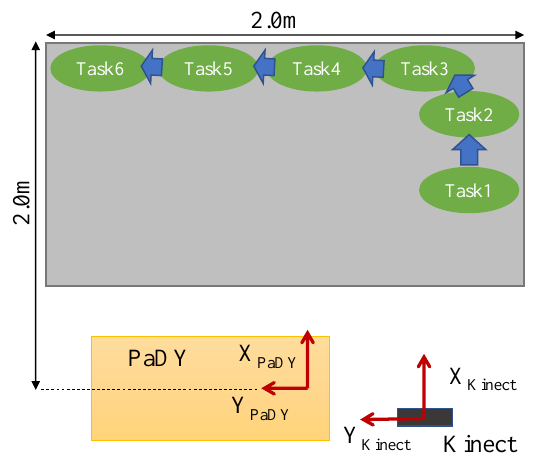
Figure 4. Experimental workspace.